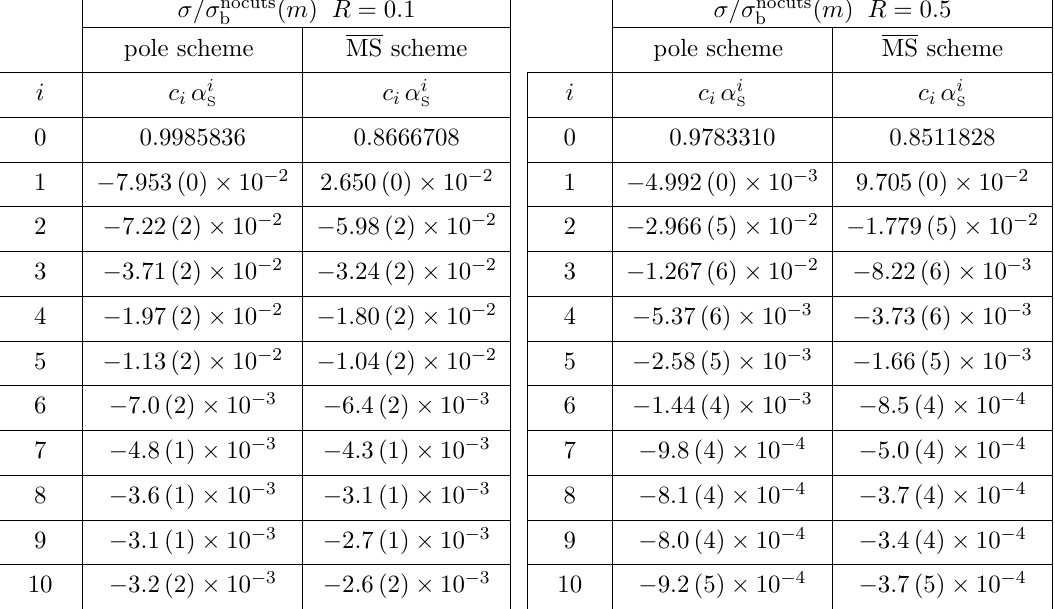
Table 4 . Coe(cid:14)cients c i of the (cid:11) expansion (8.4) of the cross section with cuts, to all orders, S computed in the large- b 0 approximation, normalized to the total Born cross section computed in the pole-mass scheme, for two di(cid:11)erent values of the jet radius ( R = 0 : 1 in the left pane and R = 0 : 5 in the right one). The errors reported in parenthesis are due to the uncertainty on the linear coe(cid:14)cient of the (cid:12)t (i.e. p 1 in eq.